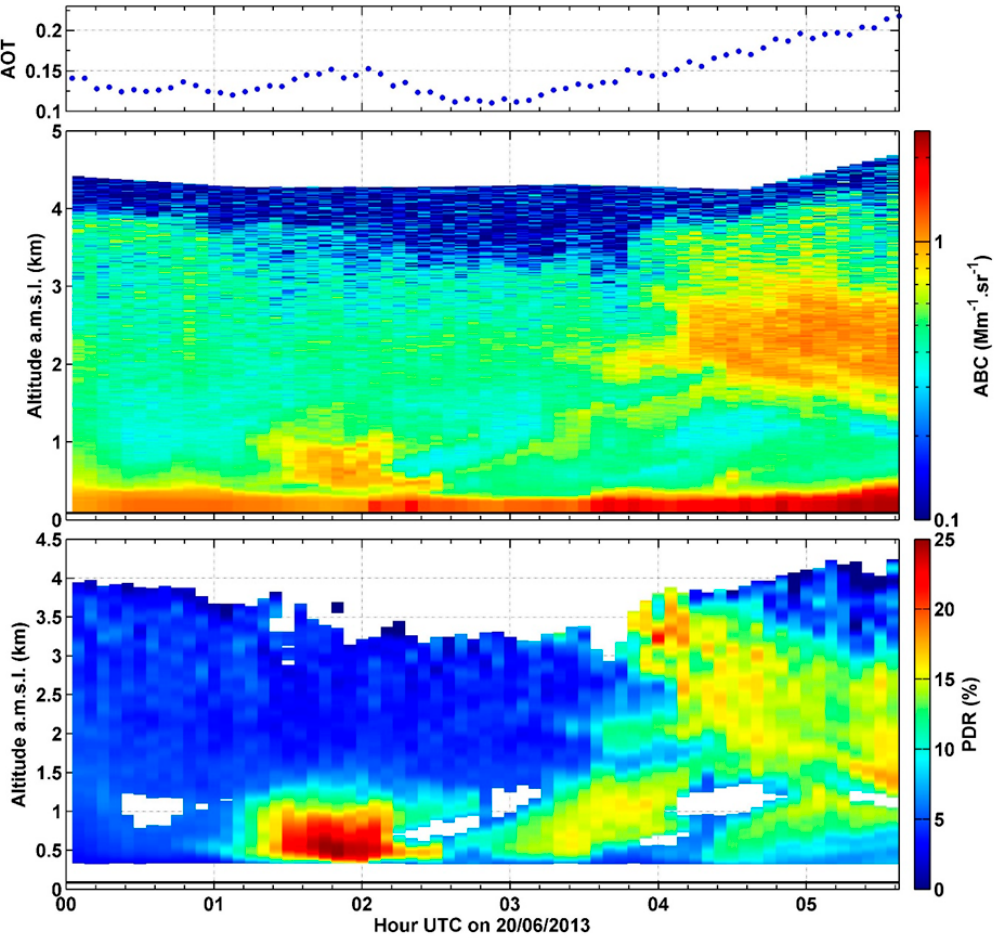
Figure 8. Same as Figure 4 but above Ufa during the morning of Thursday 20 June 2013. The 5-min average profiles are inverted using the LR profile from Figure 6b. Holes in the PDR correspond to layers where the scattering ratio is lower than the 1.05 threshold. Local time is UTC+5.